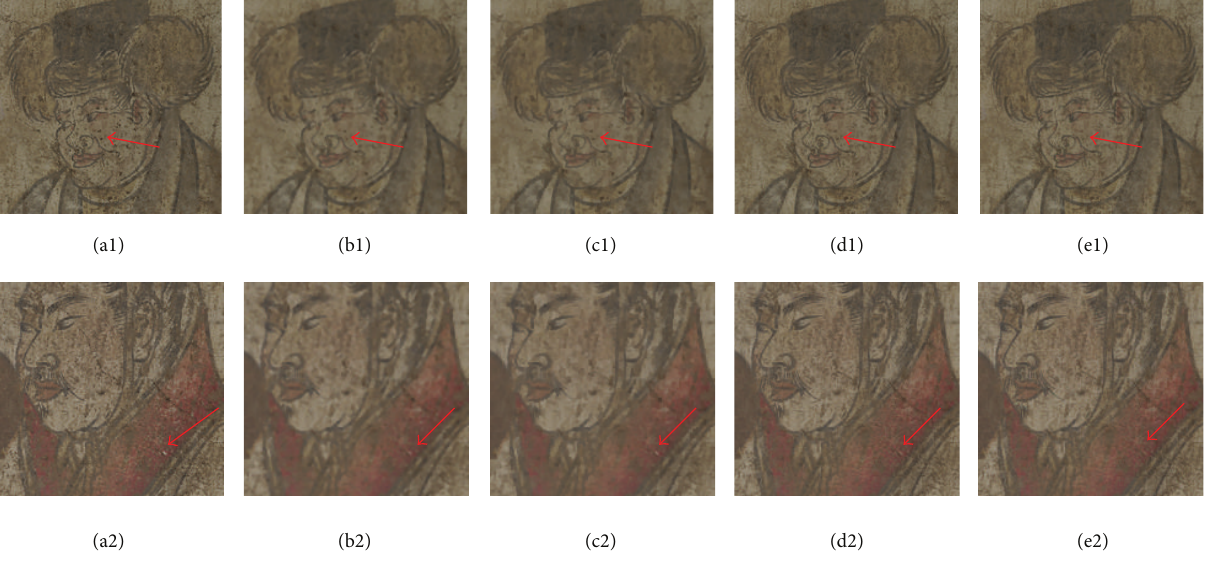
Figure 10: Mural images after removing impulse noise-like artifacts. (a1), (a2) are original images; (b1), (b2) are results of median filtering; (c1), (c2) are results of total variation denoising; (d1), (d2) are results of the wavelet-based sparse representation denoising; (e1), (e2) are results of the proposed